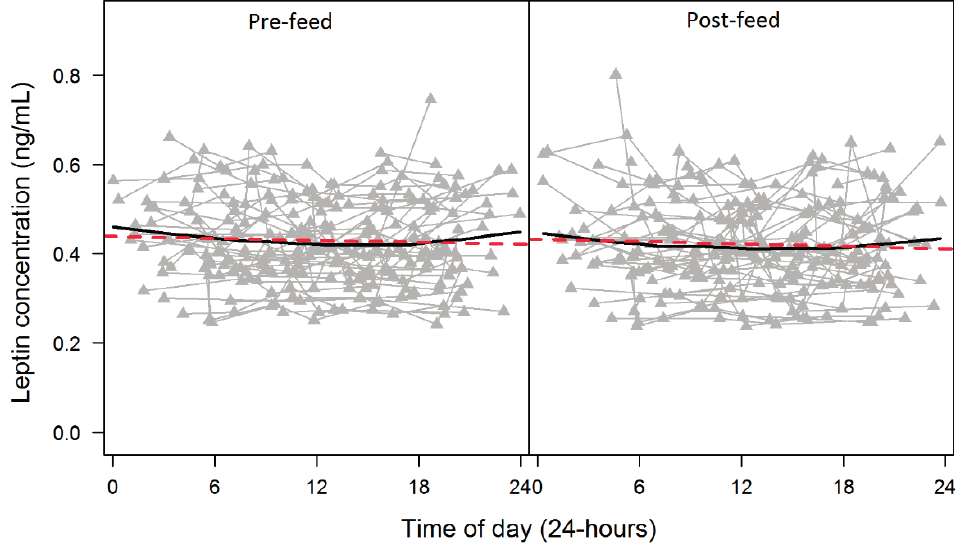
Figure 2. Changes in skim milk leptin concentration over a 24-h period for pre- and post-feed skim milk breastmilk samples. Standard regression line ( red line ) and LOESS local regression smoother ( black line ) indicate the general pattern of change across individual time points ( grey lines